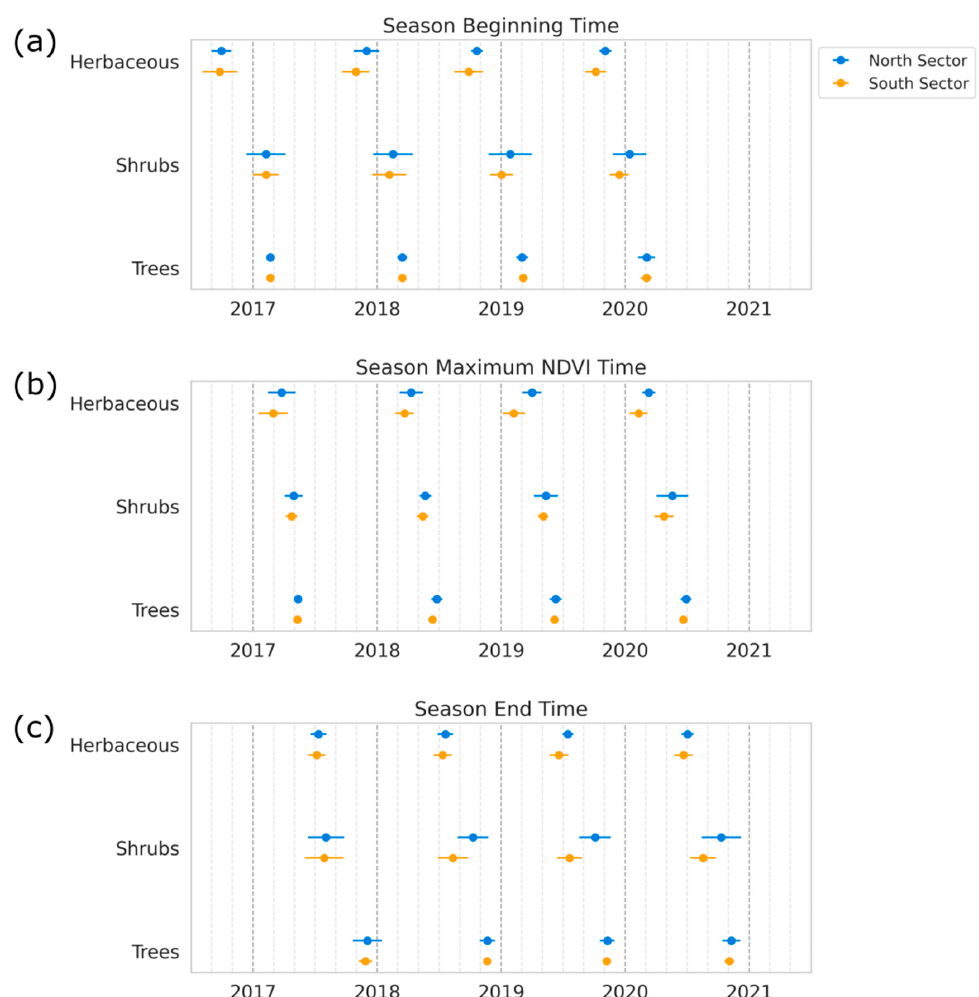
Figure A3. Changes in phenological metrics during the study period. Median values are shown for ( a ) the start of the growing season, ( b ) maximum productivity and ( c ) season end for each type of vegetation in both sectors. The error bars depict the median absolute deviations.